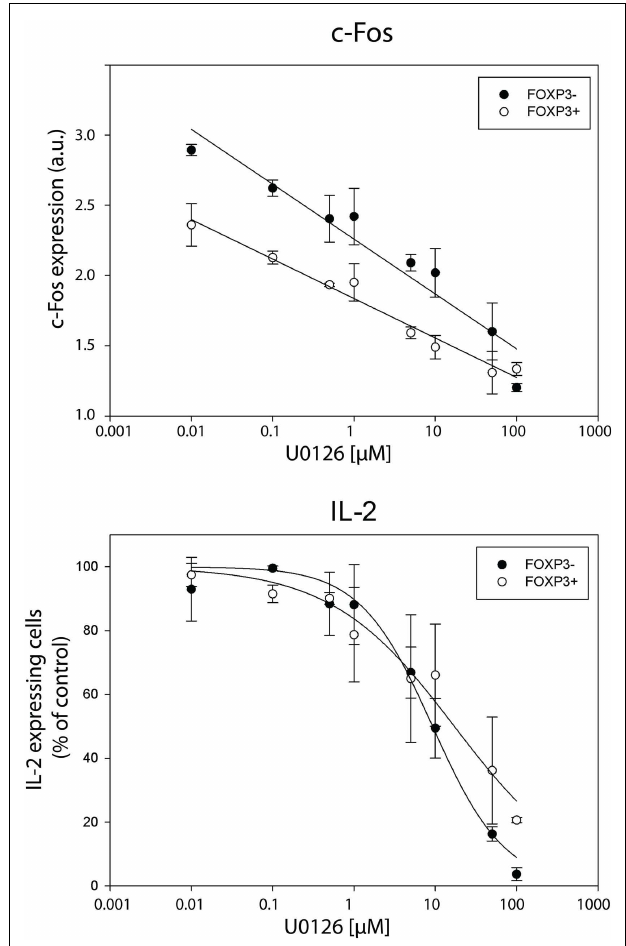
FIGURE 7 | Inhibition of c-Fos expression diminishes IL-2 expression per cell in both, FOXP3 − and FOXP3 + subpopulation. Sorted human CD4 + T cells were pre-incubated with different concentrations of the MEK1/2 inhibitor U0126 for 20min and subsequently stimulated with PMA/ionomycin for 5h. Gated memoryTh cells (CD45RO + CD45RA − ) were divided into FOXP3 − and FOXP3 + cells for analyzing c-Fos and IL-2 expression in these two subpopulations. C-Fos expression and frequencies of IL-2-expressing cells are depicted at different concentrations of U0126. Shown are mean values and the standard deviation of two independent experiments with three replicates each. Regression lines serve for guiding the